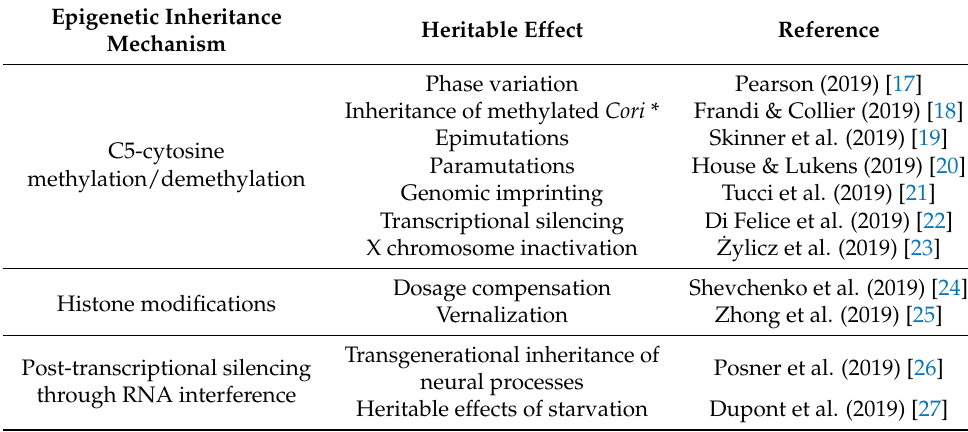
Table 1. Currently described mechanisms of stable epigenetic inheritance